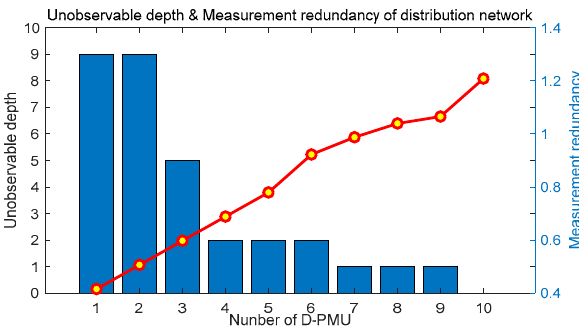
Figure 14. Unobservable depth and measurement redundancy of the Yuan’an substation.